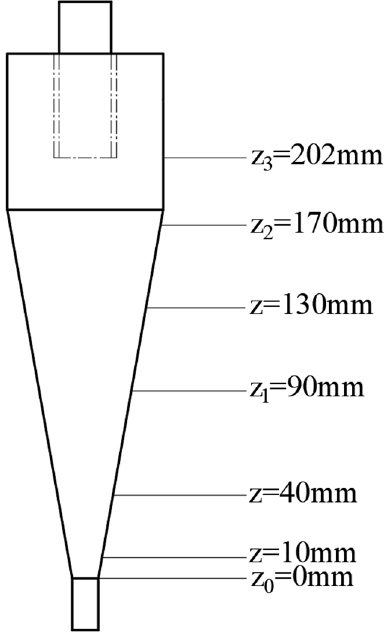
Figure 3. Schematic of axial characteristic section of the hydrocyclone .